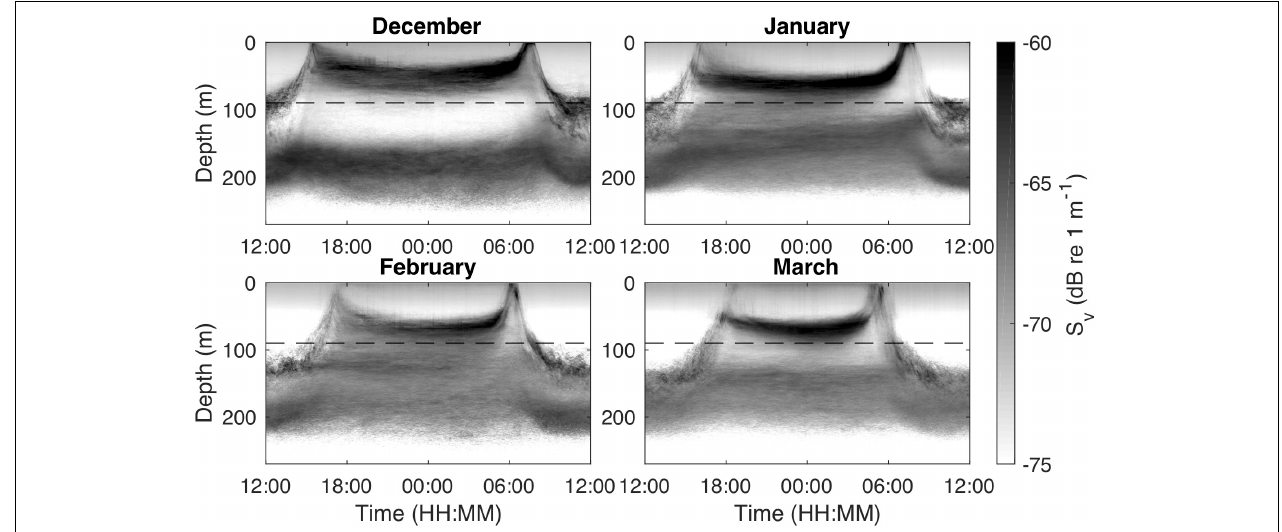
FIGURE 1 | Monthly median echograms for December 2010–March 2011 from an upward-looking, stationary 120 kHz echosounder in Masfjorden, Norway, showing scattering layer movements in the upper 300 m. The shallow scattering layer ( < 150 m depth) consists mainly of juvenile Maurolicus muelleri , the targets of this study, while the deeper scattering layer ( > 150 m depth) is mainly composed of adult M. muelleri . The dashed horizontal line indicates the depth of the 200 kHz echosounder that was used for the tracking analysis.